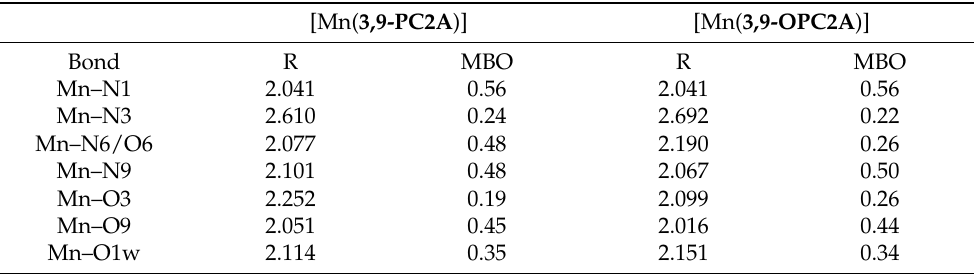
Figure 8. Ball-and-stick representation of the optimized structures of the [Mn( 3,9-PC2A )] ( left ) and [Mn( 3,9-OPC2A )] ( right ) complexes. Geometrical data on bonding can be found in Table 7 (O: red; N: blue; C: gray; H: white; and Mn: violet). Table 7. Bonding within the complexes [Mn( 3,9-PC2A )] and [Mn( 3,9-OPC2A )], characterized through selected bond lengths (R, in Å) and Mayer bond orders (MBO, in